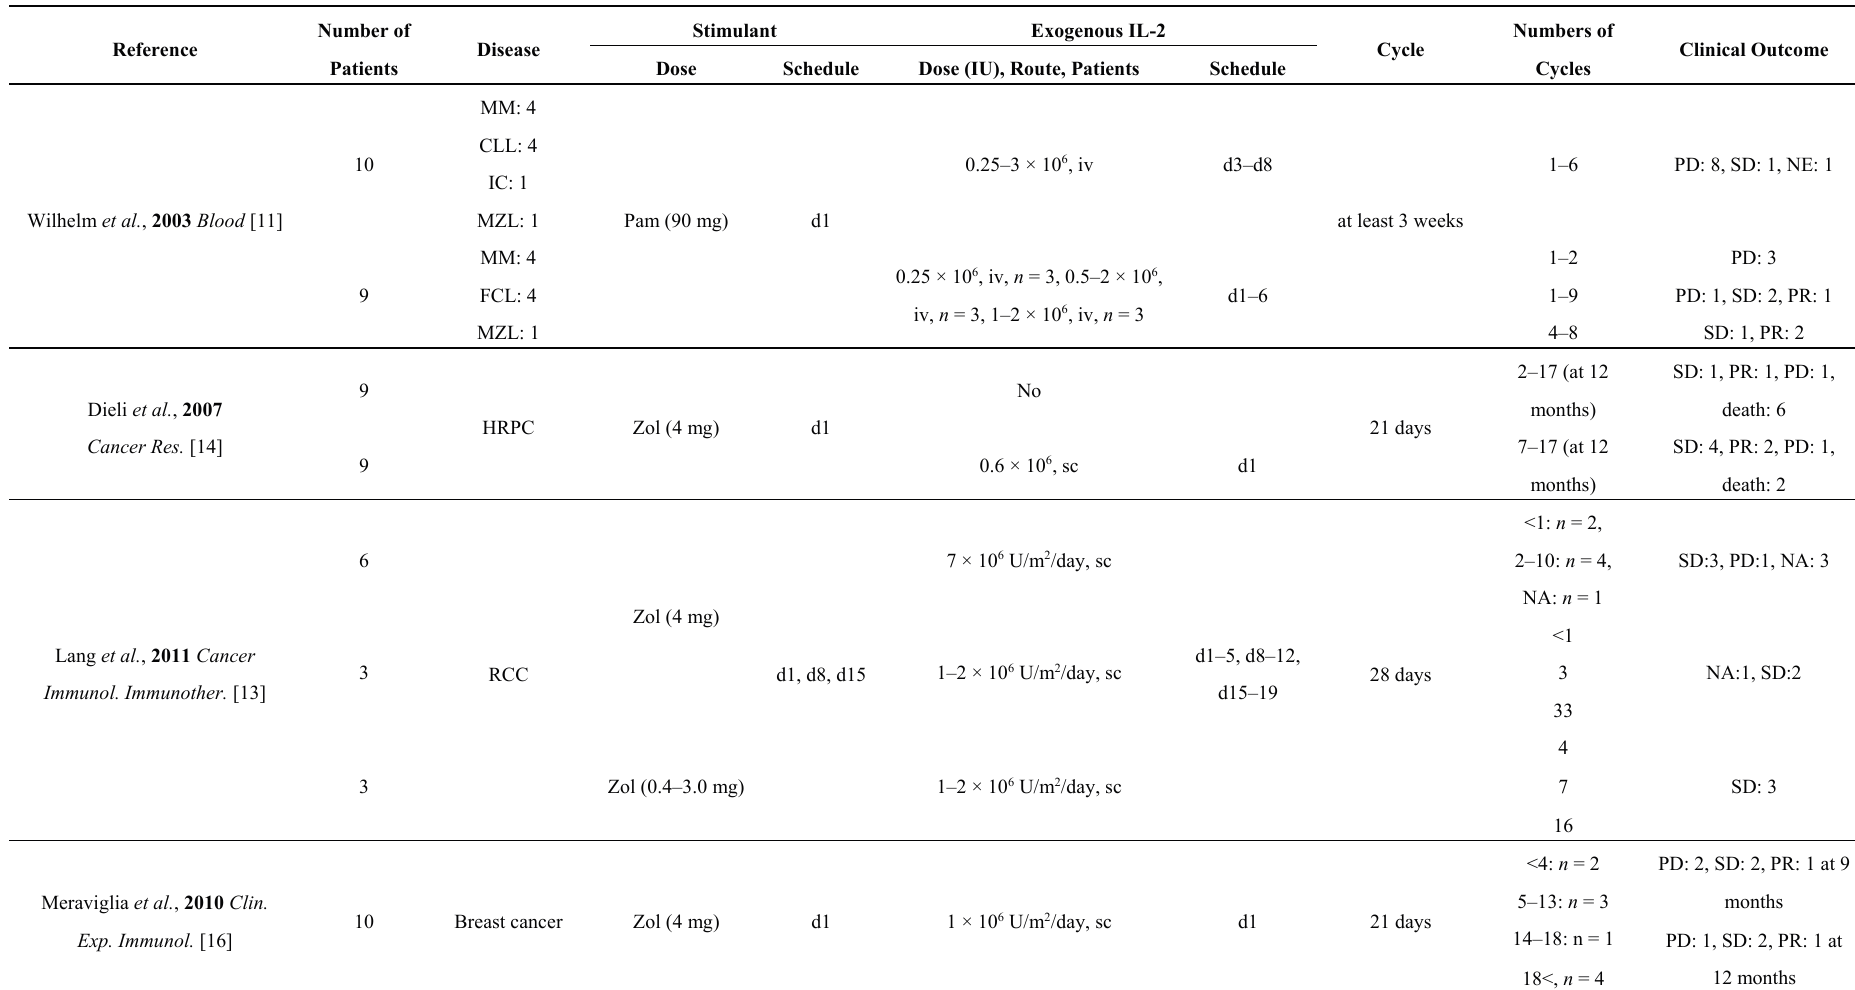
Table 1. In vivo stimulation of V γ 9V δ 2 T cells using synthetic antigens and